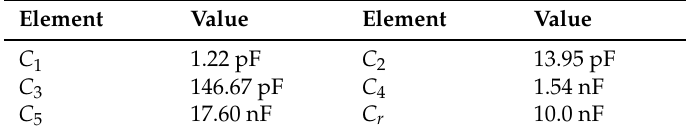
Table 6. Values of the capacitors of Figure 4.